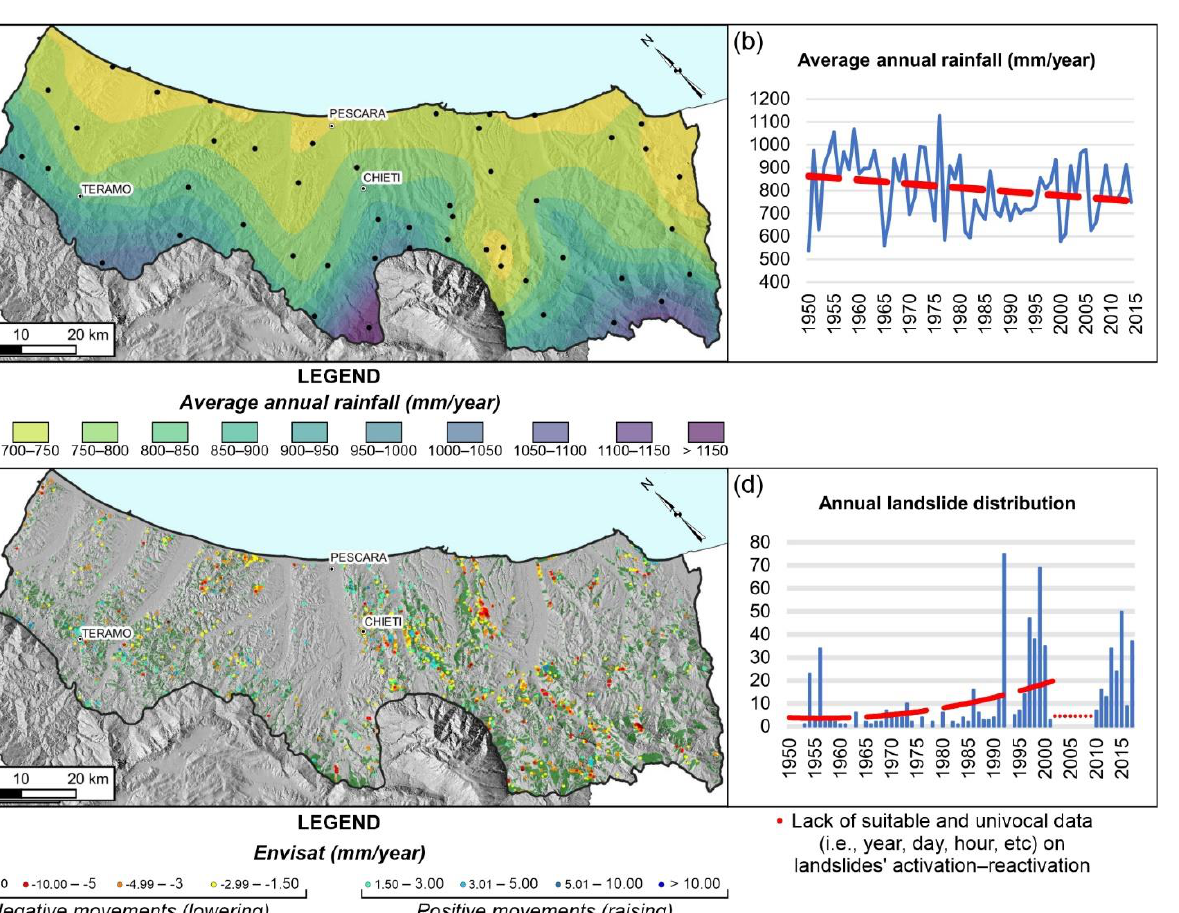
Figure 12. ( a ) Average annual rainfall map. Black dots represent rainfall gauges. ( b ) Average annual rainfall diagram from a 65-year time record (1950–2015). ( c ) InSAR observations for the selected area over the hilly–piedmont area. Mean line-of-sight (LOS) velocity for the period 2002–2010 from Envisat descending track. Only the Persistent Scatterers (PSs) that fall within the landslide areas (dark green polygons) have been selected and are represented as colored dots. Positive values represent the motion of the ground toward the satellite (raising), and negative values represent the motion away from the satellite (lowering). Green polygons represent landslide bodies detected by the IFFI Project [60]. ( d ) Distribution of annual landslide occurrences over the 1950–2015 period (derived from [60,65,86]).